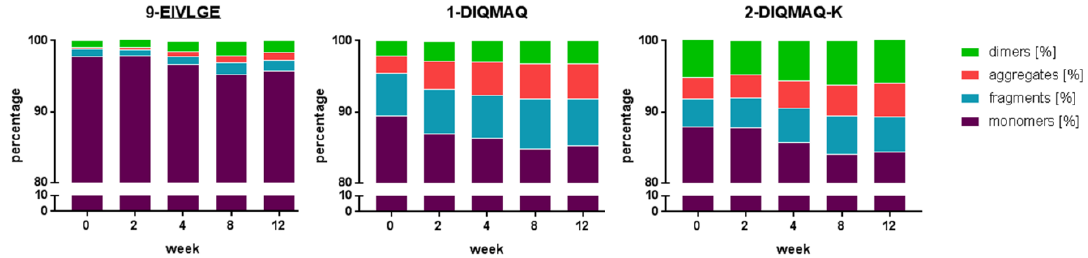
Figure 7. Aggregation / fragmentation of BaxM159 variants determined by size-exclusion chromatography (SEC) over a time course of 12 weeks at 4 °C.